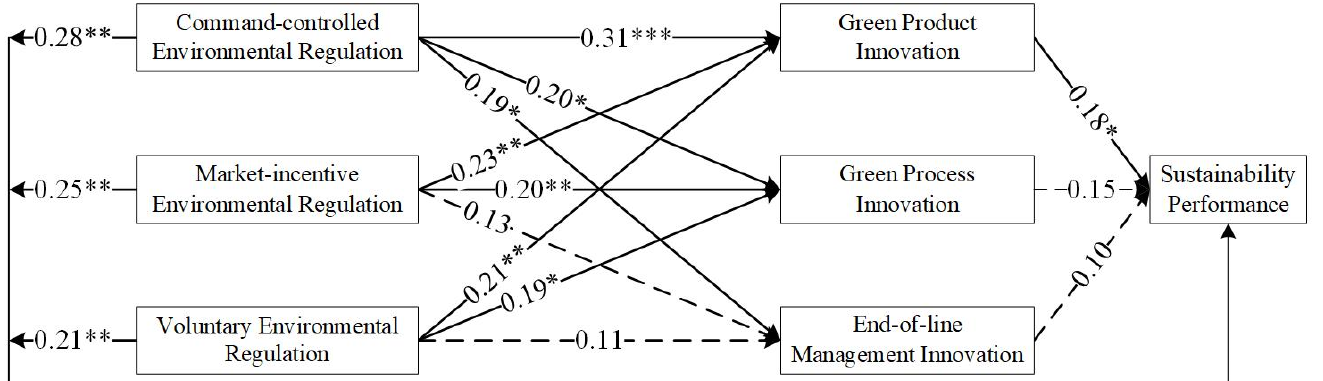
Figure 4. Results of the hypothesized model in Central China. * denotes p < 0.05; ** denotes p < 0.01; *** denotes p < 0.001.